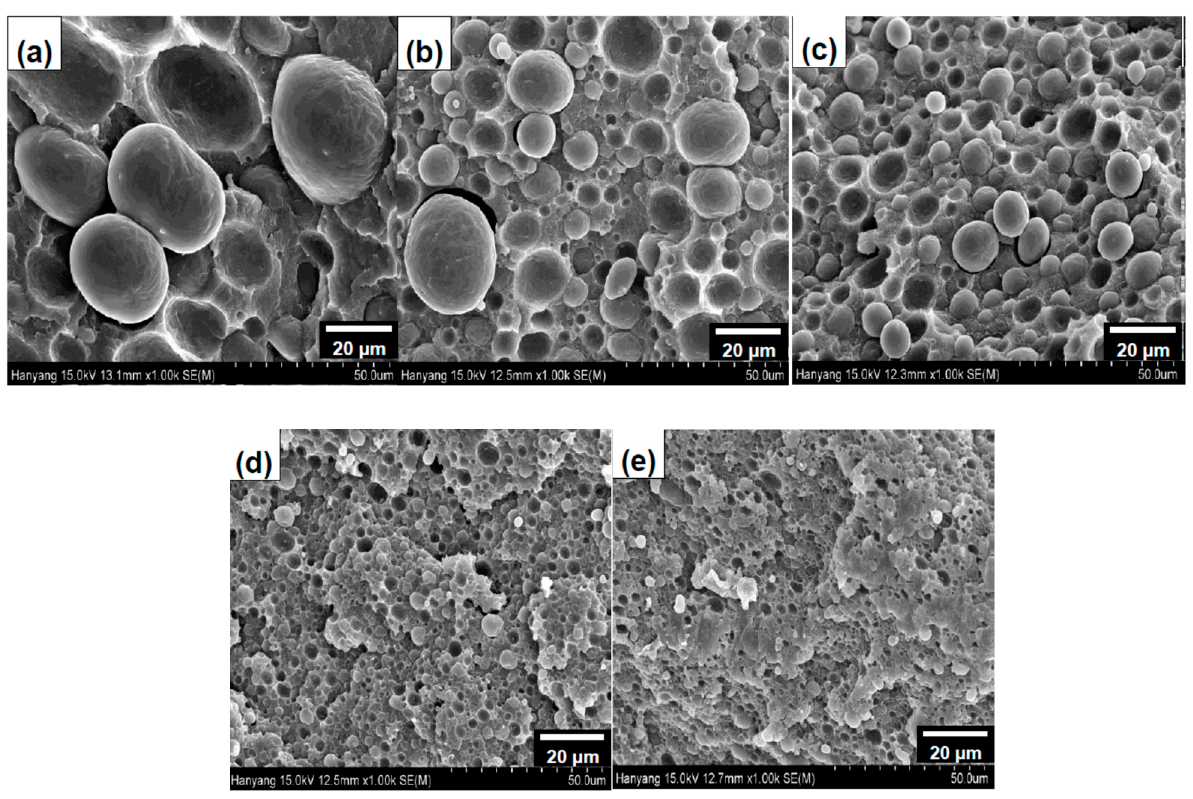
Figure 2. FE-SEM images of polyamide12 (PA12)/polyolefin elastomer (POE)/G-POSS blends with different G-POSS contents of ( a ) 0, ( b ) 1, ( c ) 3, ( d ) 5 and ( e ) 10 phr.